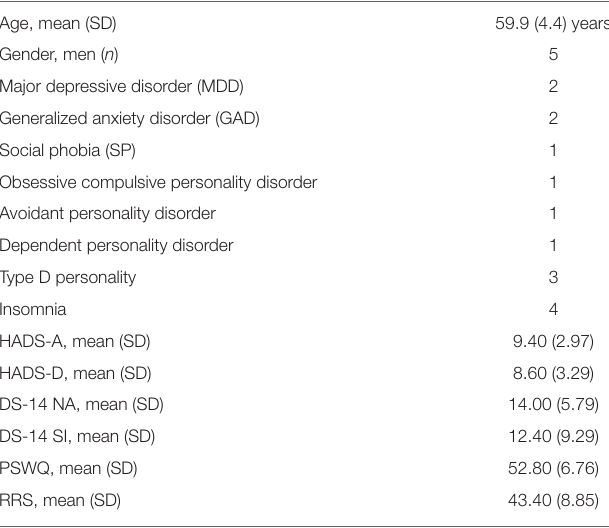
TABLE 1 | Patient characteristics at